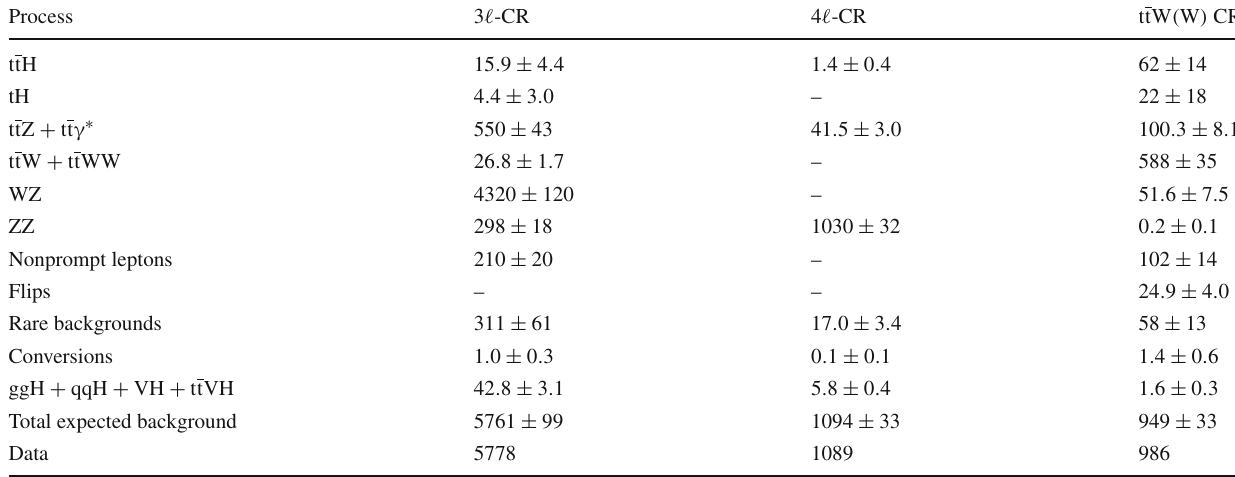
Table 6 Number of events selected in the 3 (cid:4) - and 4 (cid:4) -CRs and in the CR for the ttW ( W ) background, compared to the event yields expected from different types of background and from the ttH and tH signals,